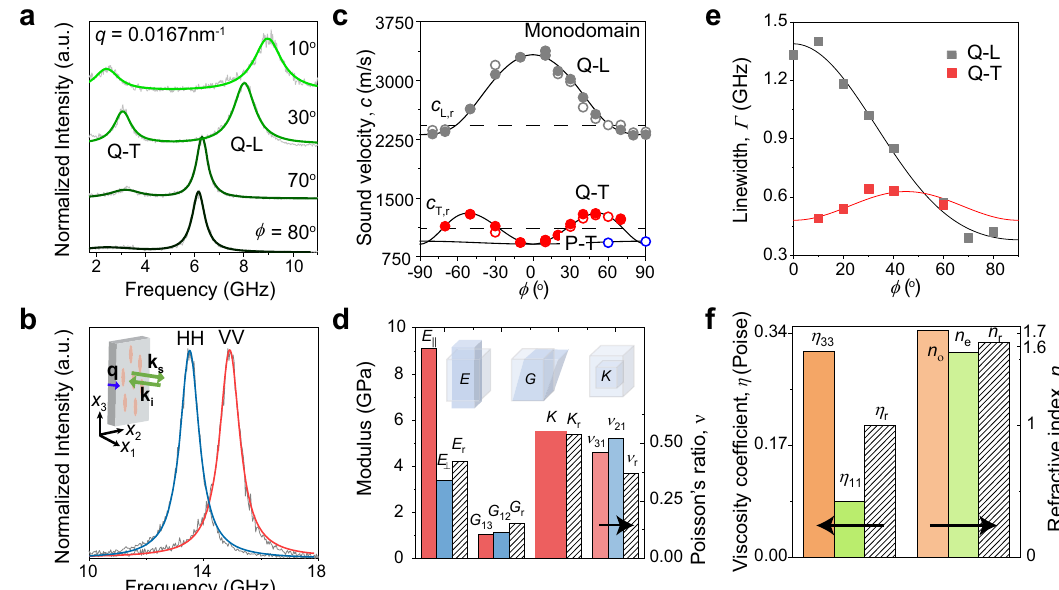
Fig. 2 | OrientationdependentBrillouinlight spectroscopy frommonodomain LCE fi lm. a Polarized BLS spectra of the monodomain LCE fi lm at different orien- tation angles ϕ and a constant wave vector, q =0.0167nm − 1 , represented by Lor- entzian shapes (greenlines).Thehighand low frequencypeaksare assigned to the quasi-longitudinal(Q-L)andquasi-transverse(Q-T)phonons,respectively. b VVand HHspectraofthemonodomainLCE fi lmrecordedatbackscatteringgeometrywith incidentangle β =0 o .Atthisgeometry, q isnormaltothe x 2 - x 3 planeofthe fi lmand hence normal to the director n . c The sound velocity, c , computed from the fre- quencies of Q-L (gray symbols), Q-T (red symbols) and pure-transverse (P-T, blue symbols) modes, as a function of the orientation angle ϕ . The solid and open symbols indicate the data obtained from polarized (VV) and depolarized (VH) BLS spectra, respectively. The solid lines denote the representation of sound velocities byChristoffel ’ sequation(Eq.1and2inMethodssection),whereasthedashedlines indicatetheexperimentalvaluesofthelongitudinal(LA)andtransverse(TA)sound